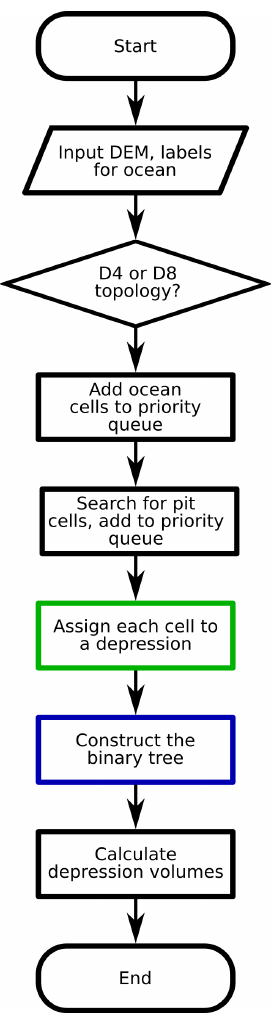
Figure 4. Main steps taken by the depression hierarchy algorithm. More detail on the green and blue boxes can be seen in Figs. 5 and